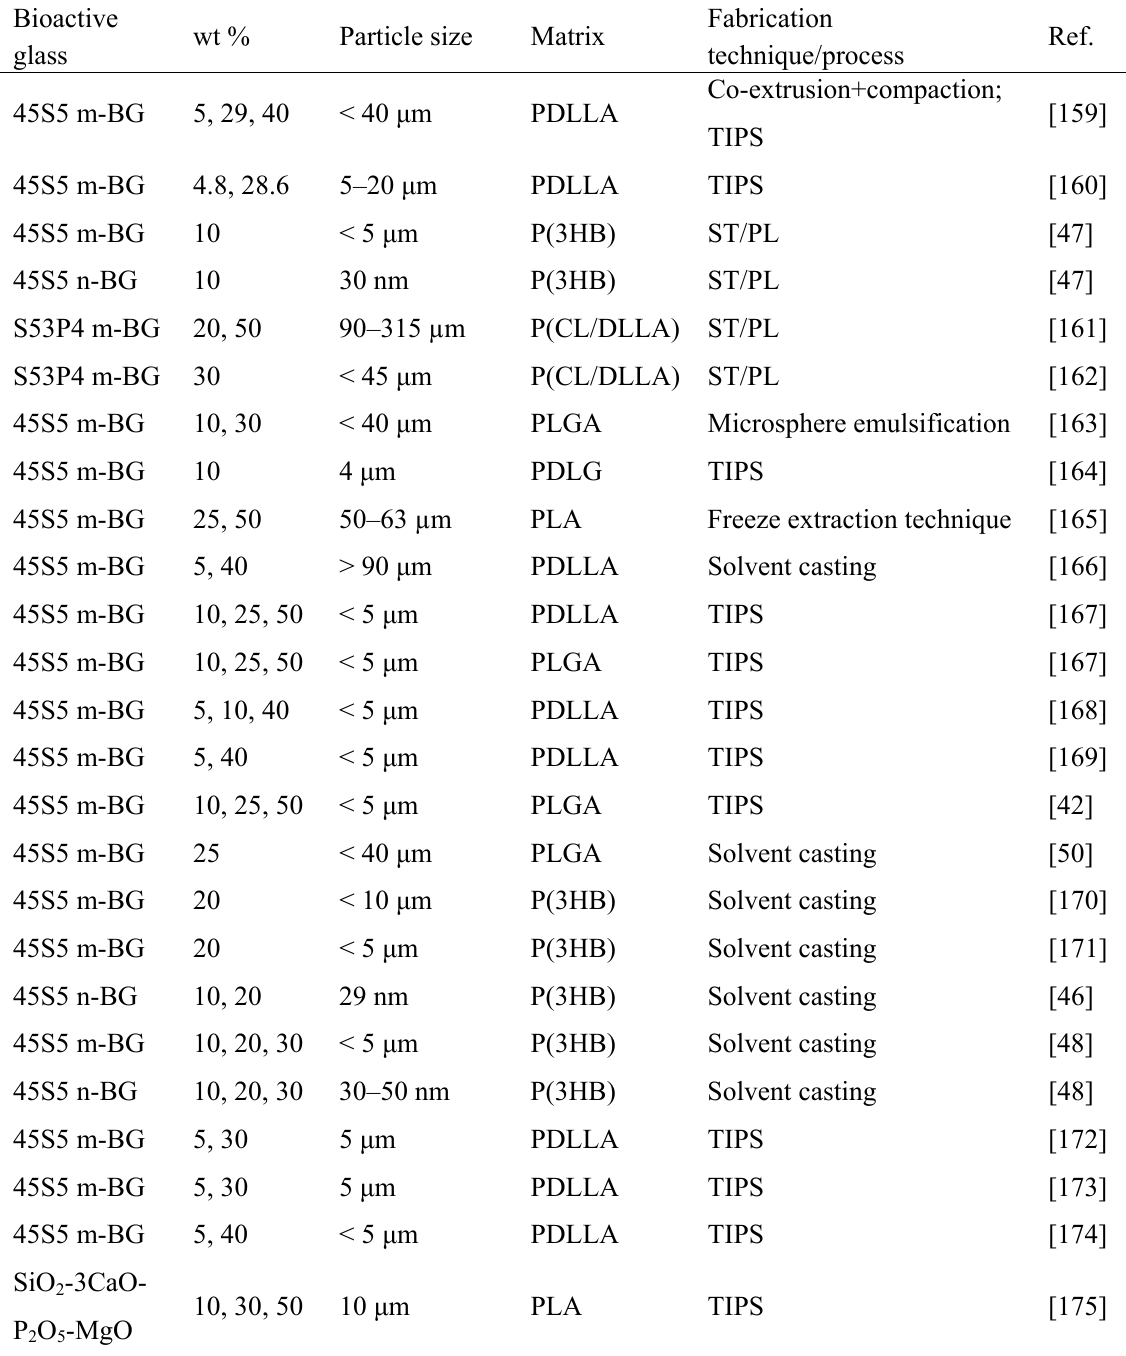
Table 3. Overview on studies performed on BG containing composite scaffolds for bone TE. Key: PDLLA, poly(D, L lactide); P(3HB), poly3-hydroxybutyrate), P(CL/DLLA), poly( ε -caprolactone/D, L lactide); PLGA, poly(lactic-co-glycolic acid); PDLG, poly(D, L lactide-co-glycolide); PLA, poly(L lactide); S53P4, 53 wt % SiO CaO, 4 wt % P O ; m-BG, micron-sized bioactive glass; n-BG, nano-sized bioactive glass. 2 5 ST/PL, sugar template/particulate leaching; TIPS, thermally induced phase